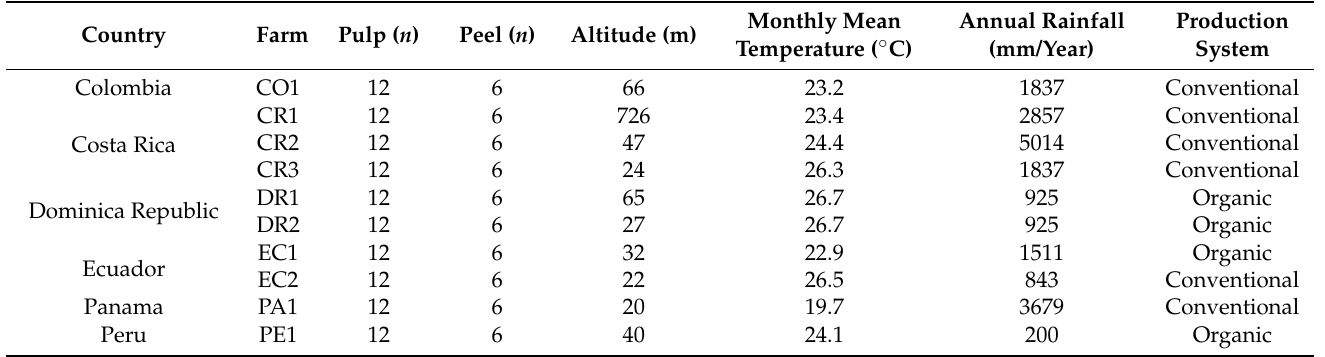
Table 1. The banana pulp and peel samples collected from different countries and related growing conditions.